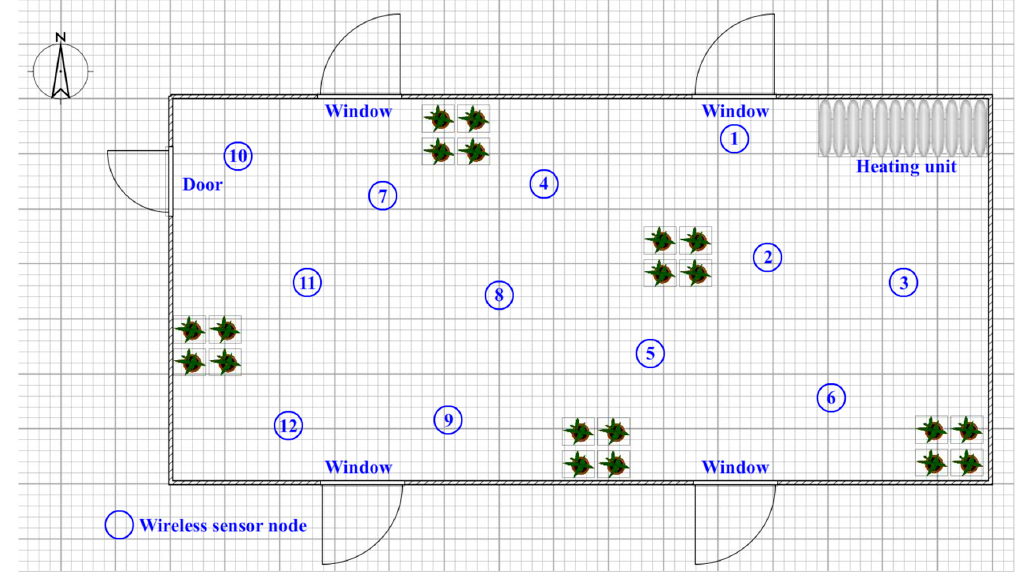
Figure 1. Illustration of a sensor network deployed in a greenhouse.